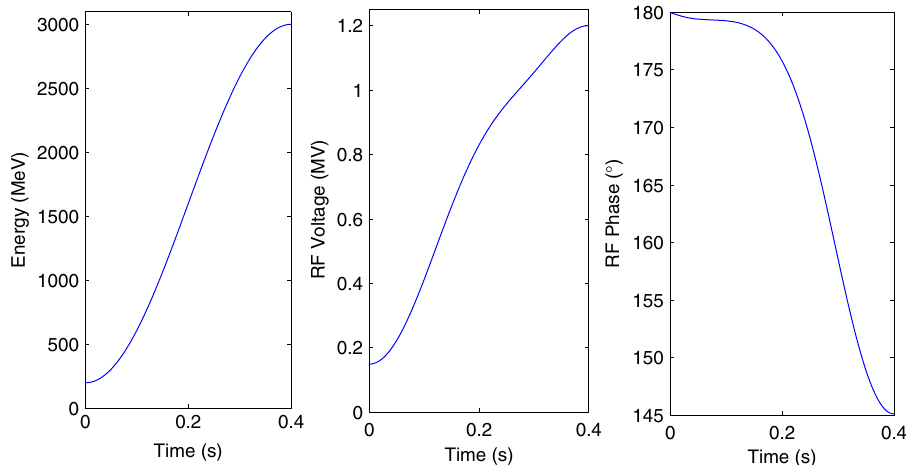
FIG. 12. The energy (left), rf voltage (center), and phase (right) ramp in the booster.